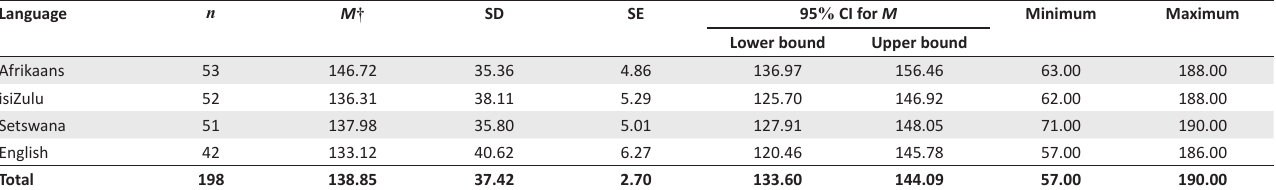
TABLE 2: Mean total Mullen Scales of Early Learning raw scores, standard deviations, confidence intervals and the range of scores for each language group. Language